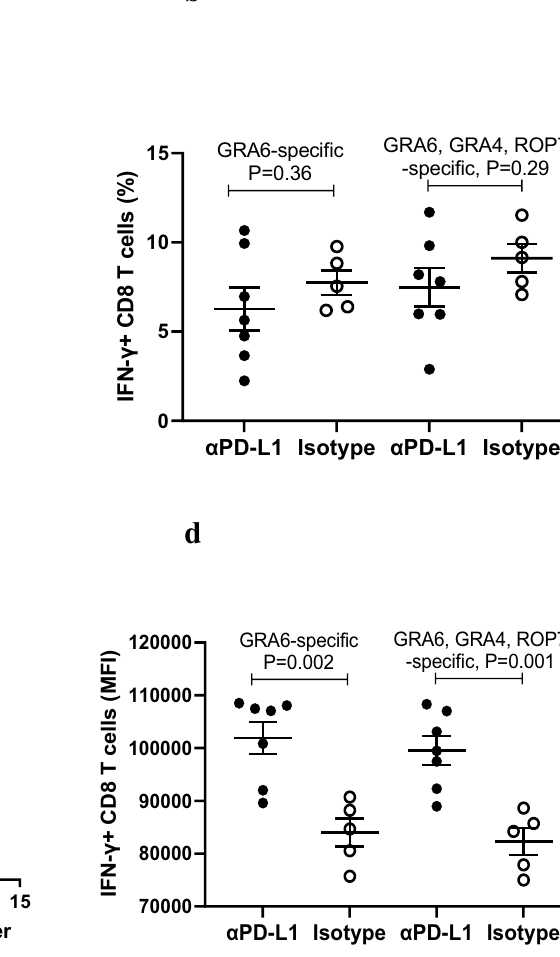
Figure. 3. Frequency of antigen-specific CD8 + T cell response and intensity of IFN-γ staining after PD-L1 blockade. Splenocytes were harvested from Toxoplasma -infected mice treated with αPD-L1 (n = 7) or isotype control (n = 5). Cells were incubated overnight with individual peptides (GRA6, GRA4, and ROP7) or a mixture of the 3 peptides, followed by CD3, CD8, and IFN-γ staining. ( a ) Representative flow cytometry staining of GRA6, GRA4, ROP7, and pooled peptides-specific IFN-γ-secreting CD8 + T cells. ( b ) The frequency of GRA6-specific and pooled peptide-specific IFN-γ-secreting CD8 + T cells of αPD-L1 and isotype-treated mice. ( c ) Correlation between the frequency of GRA6 tetramer-positive CD8 + T cells and GRA6-specific IFN-γ- secreting CD8 + T cells. ( d ) The mean fluorescence intensity (MFI) of IFN-γ staining of CD8 + T cells specific for GRA6-epitope or the mixture of the 3 epitope-specific peptides in αPD-L1 and isotype-treated mice. Data are shown as mean ± SEM, with individual data points. P values are calculated by Student’s t-test ( b & d ) or Pearson’s correlation analysis ( c